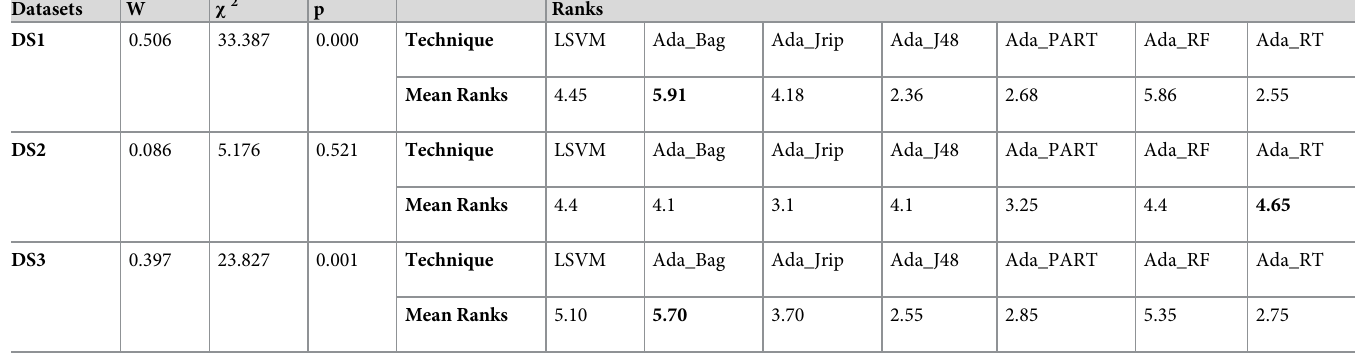
Table 13. Rankings of existing best performing classifier (LSVM) and AdaBoost ensemble classifiers, based on Kendall’s W test results using the MDDR dataset by sensitivity measure. Datasets